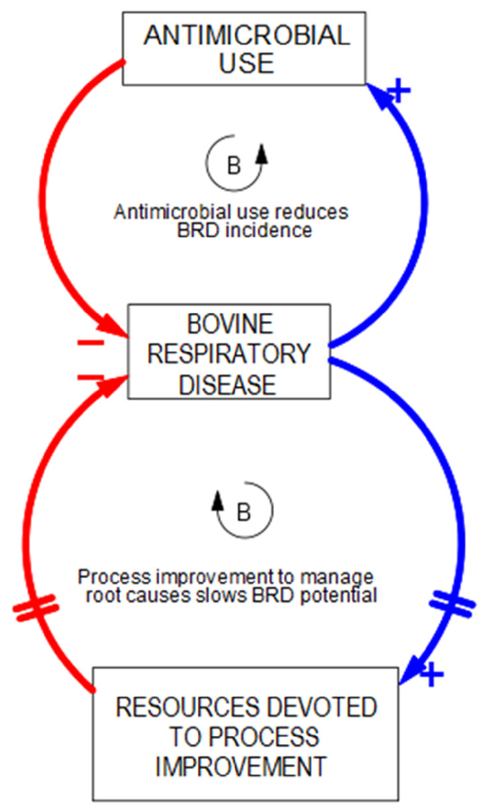
Figure 5. Causal loop diagram representing the basis of the archetype, “Shifting the Burden”.